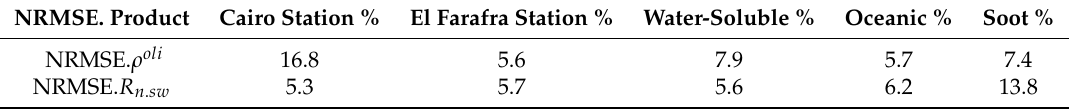
Table 8. NRMSE of the shortwave net radiation, R n . sw , and the surface reflectance, ρ oli , obtained for each aerosol condition with respect to the values in the dust-like reference case over the study area. The NRMSEs were achieved considering the second to the fifth OLI